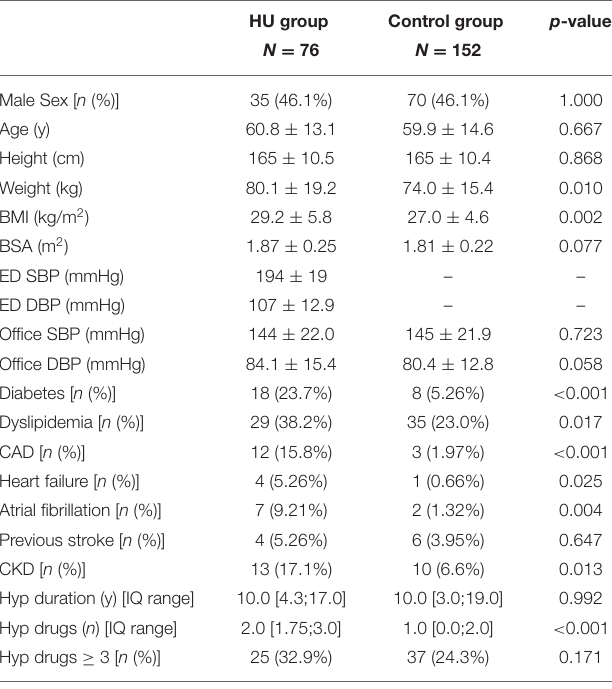
TABLE 3a | Comparison between the HU group and the Control group (demographic and clinical characteristics). HU group